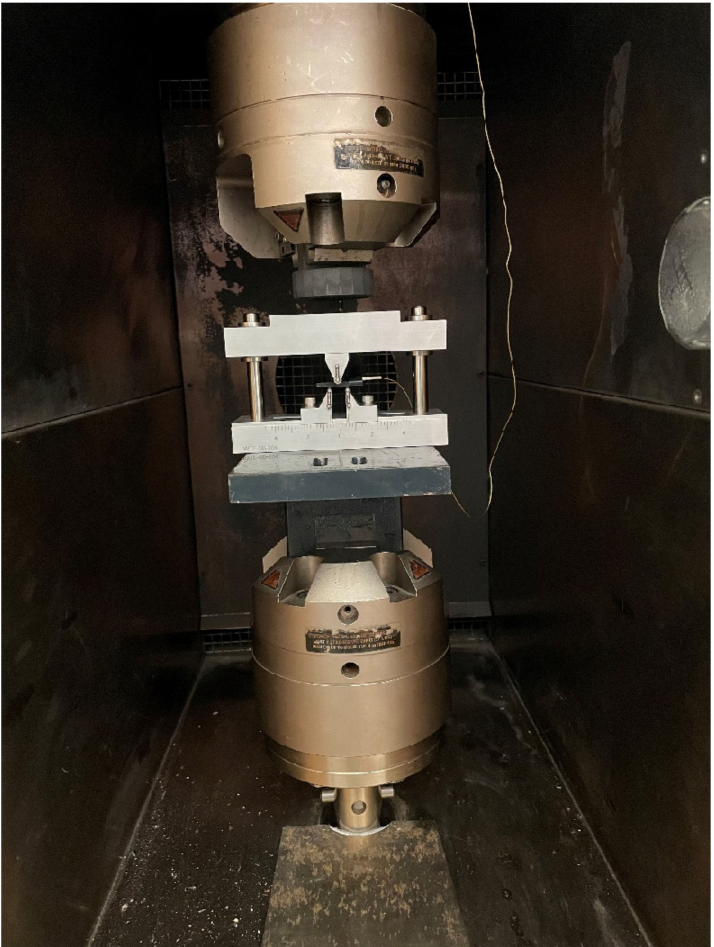
Figure 1. Test Setup showing Short Beam Shear Test Setup with AE sensor inside the environmen- tal